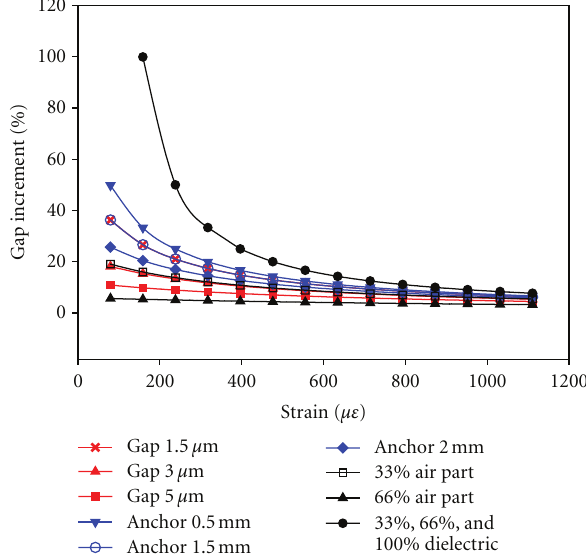
Figure 17: Percentage of gap increment for all